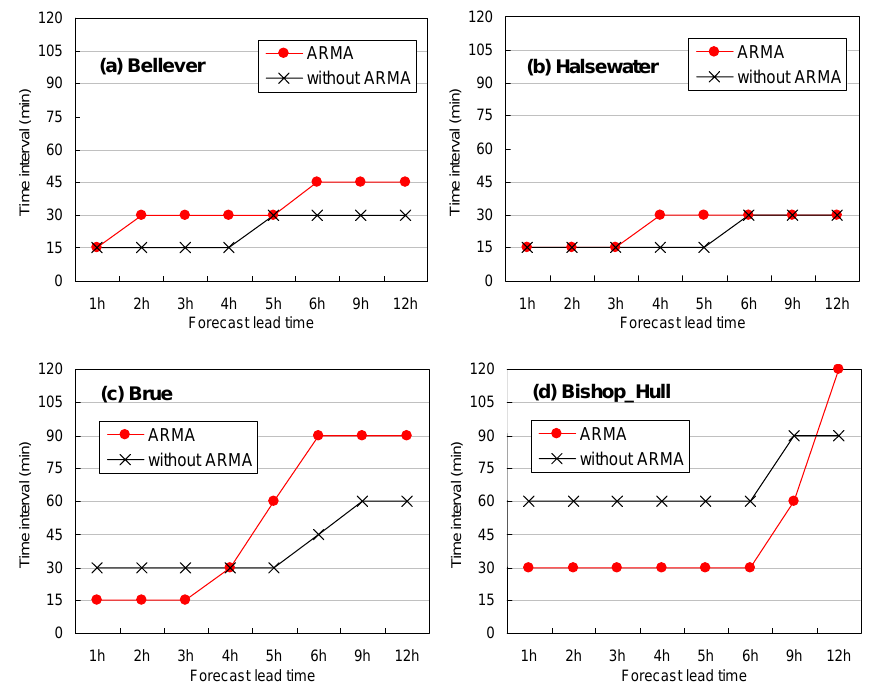
Figure 9 Comparisons on the data time interval patterns when the real-time hydrological forecasts are made in the two circumstances with/without the updating of the ARMA model.